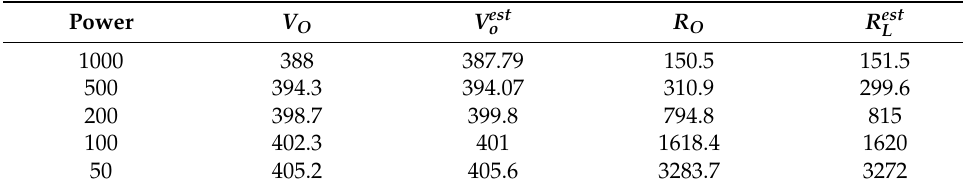
Figure 12. Simulation results, P O = 50 W. Table 2. Simulation results